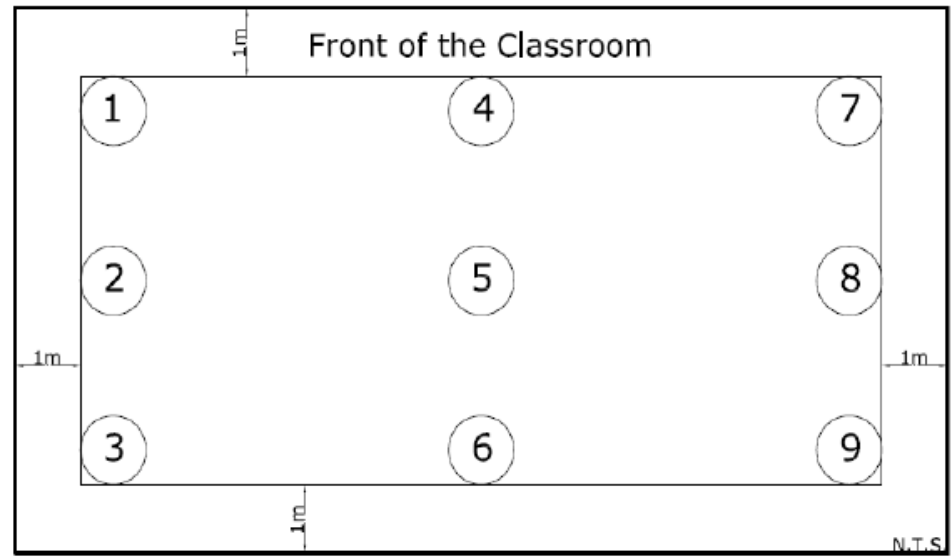
Figure A1. Plan Showing Dataloggers Placement Distribution Across the Classroom.